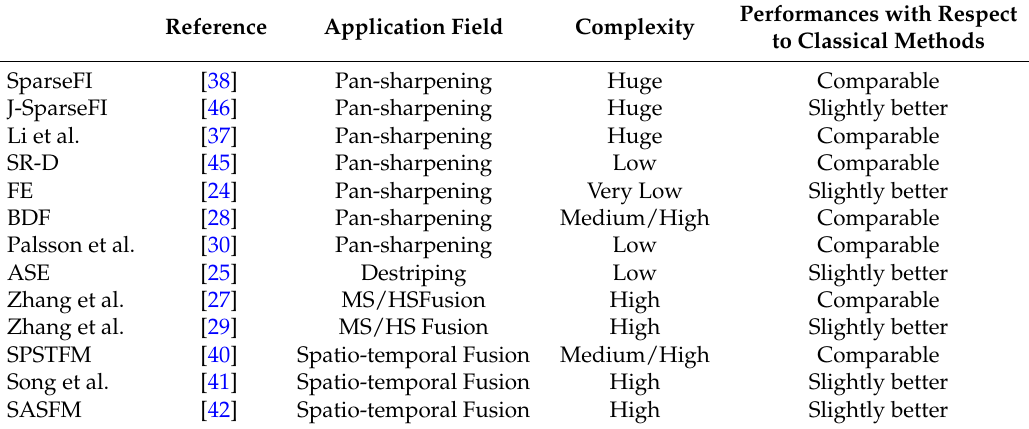
Table 2. A synoptic view of recent remote sensing image fusion algorithms based on the super- resolution paradigm (FE: Filter Estimation; BDF: Bayesian Data Fusion; ASE: Adaptive Structuring Element; SPSTFM: sparse-representation-based spatio-temporal reflectance fusion model. SASFM: Spatial And Spectral Fusion